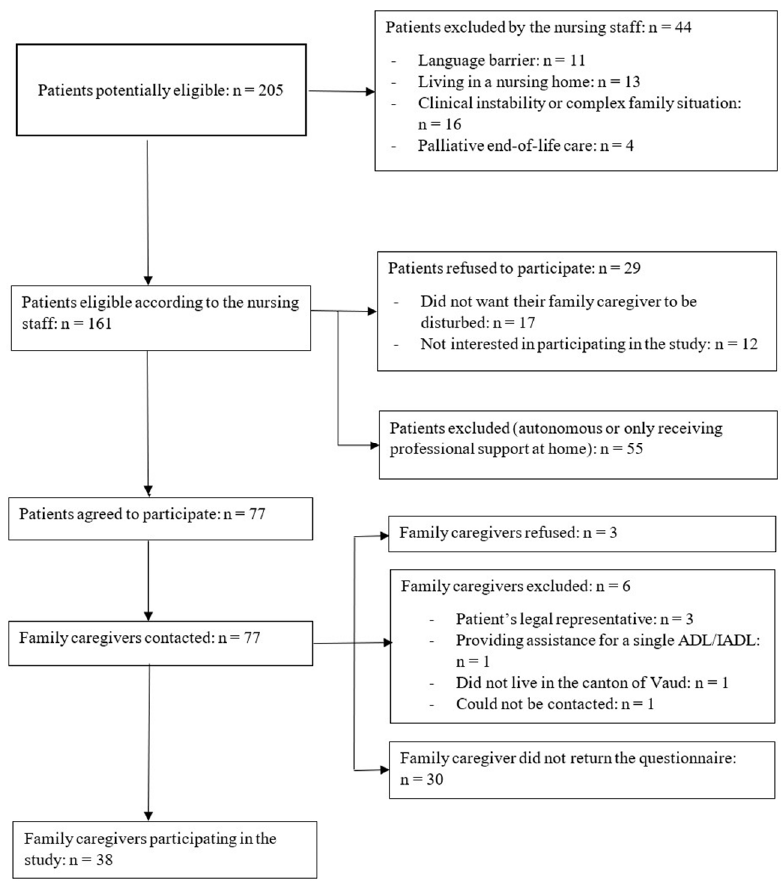
Figure 1. Flow diagram.